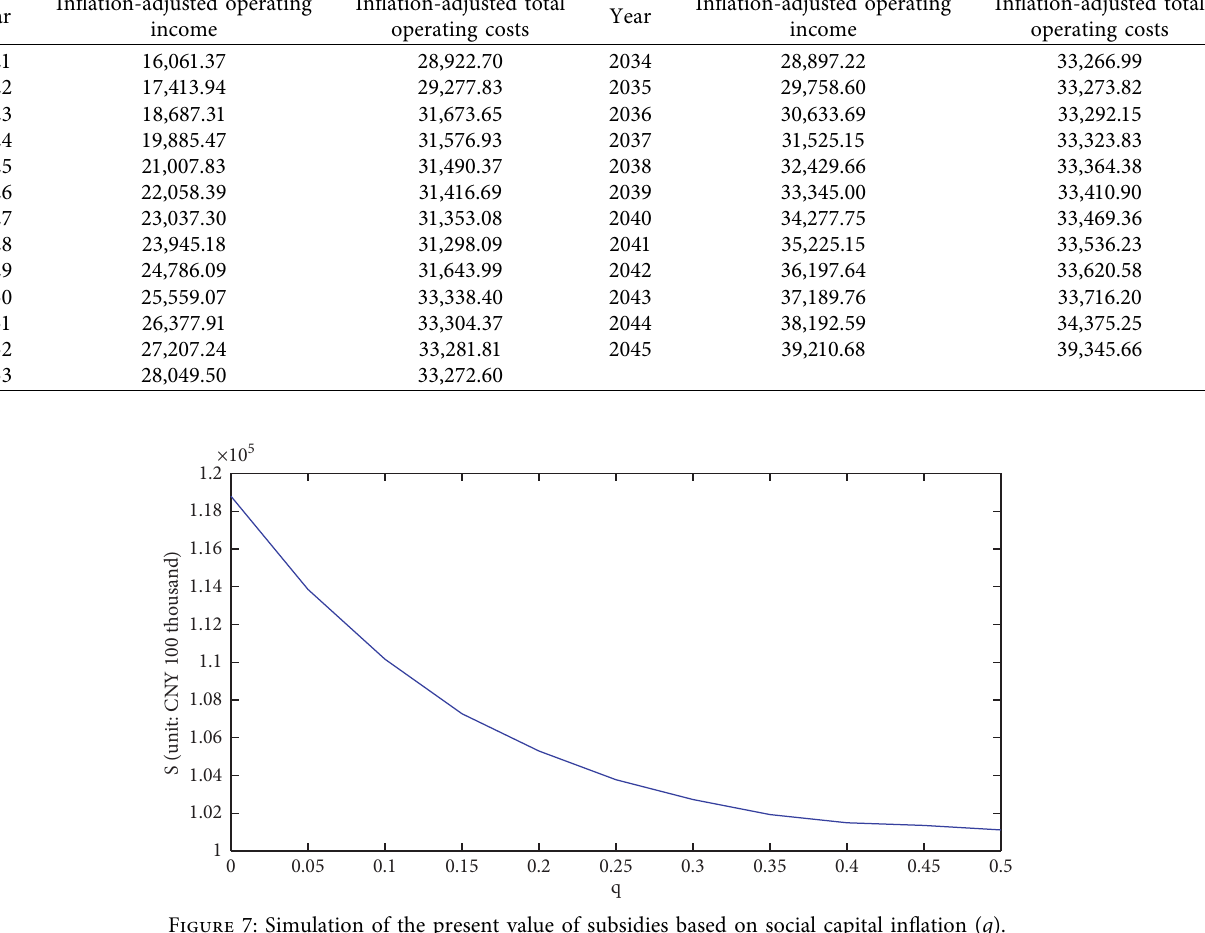
Figure 7: Simulation of the present value of subsidies based on social capital inflation ( q